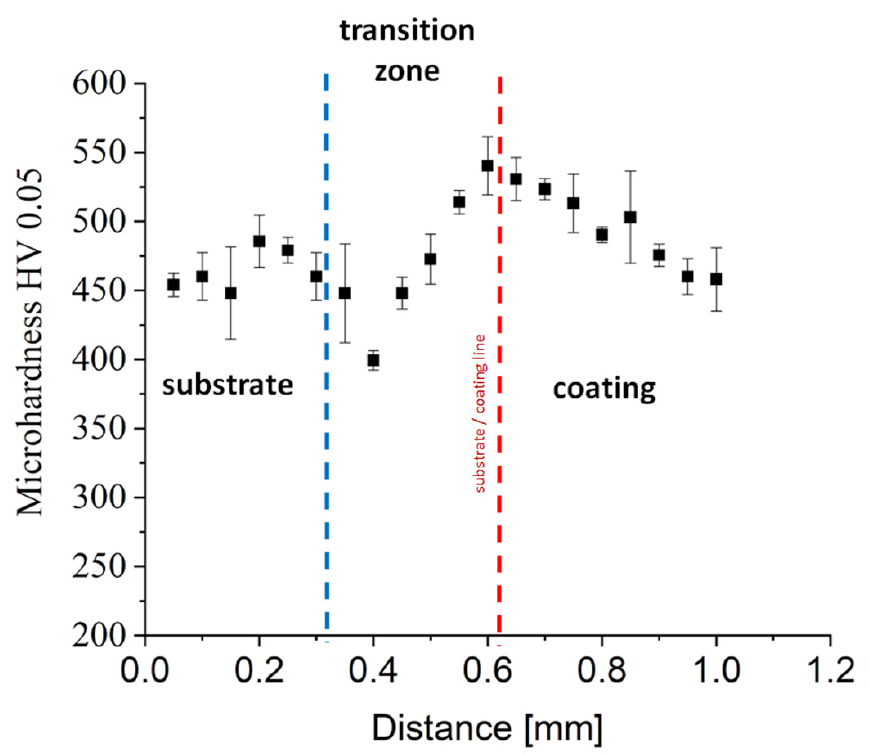
Materials 2021 , 14 , x FOR PEER REVIEW Figure 8. The microhardness distribution of the Co-6 coating #4 deposited using the LENS process.